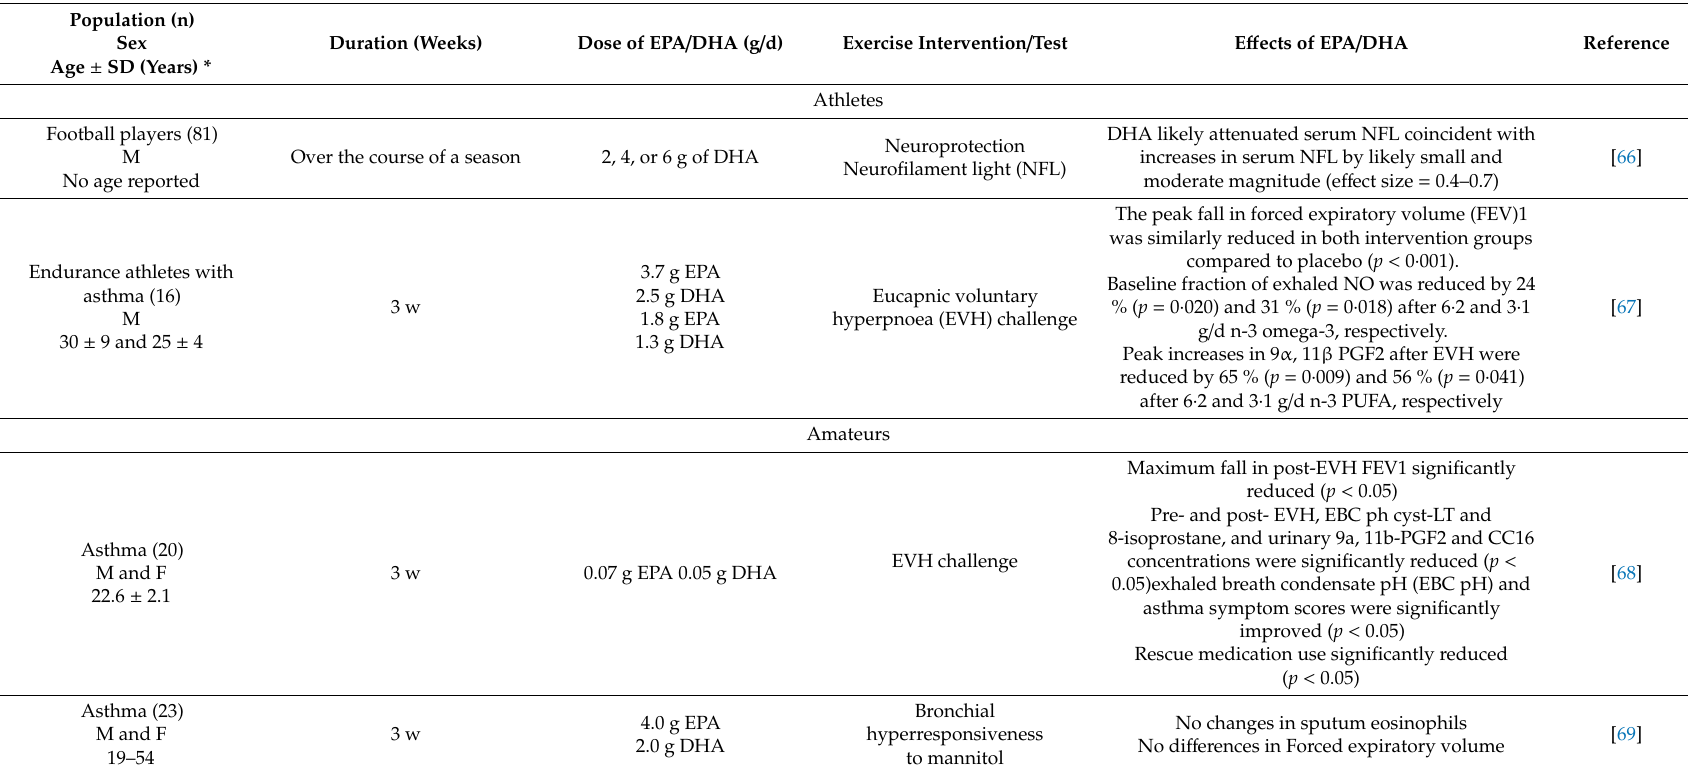
Table 3. E ff ects of EPA / DHA supplementation with a focus on injury / illness-related outcomes in athletes and